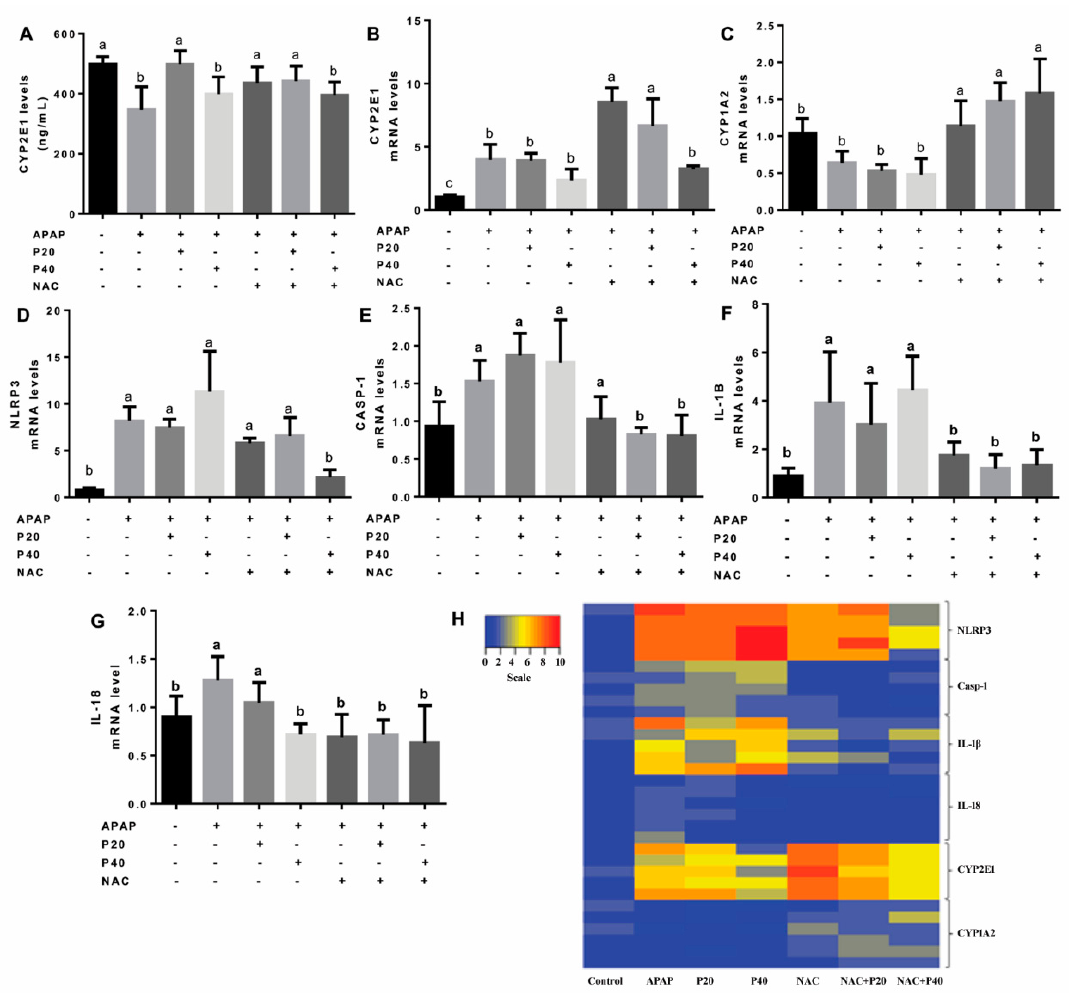
Figure 4. Levels of the CYP2E1 isoenzyme ( A ). Evaluation of the expression of CYP2E1 ( B ) and CYP1A2 ( C ) isoenzyme genes of cytochrome P450 and genes of the inflammasome pathway ( D – G ). Statistical analysis was performed using one-way analysis of variance and Tukey’s post-test. Different letters (a, b, c) indicate significant difference between groups ( p < 0.05), whereas the same letters indicate no significant difference between groups ( p > 0.05). (+) Presence or ( − ) absence of paracetamol, piperine 20 mg/kg, piperine 40 mg/kg, N-acetylcysteine. The mRNA heat map shows upregulated and downregulated genes with red and blue coloration, respectively ( H ). The genes evaluated were from the inflammasome pathway ( NLRP-3 , Casp-1 , IL-1 β and IL-18 ) and cytochrome P450 ( CYP2E1 and CYP1A2 ) ( B ). Abbreviation: CYP1A2: cytochrome P450 1A2; CYP2E1: cytochrome P450 2E1; Casp-1: caspase 1; IL-1 β - interleukin 1 β ; IL-18: interleukin 18; and NLRP3: pyrin domain